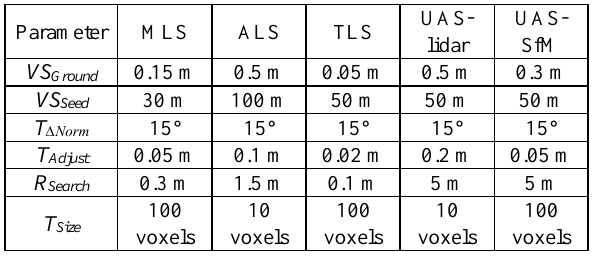
Table 2 Summary of the parameters used in the tests.